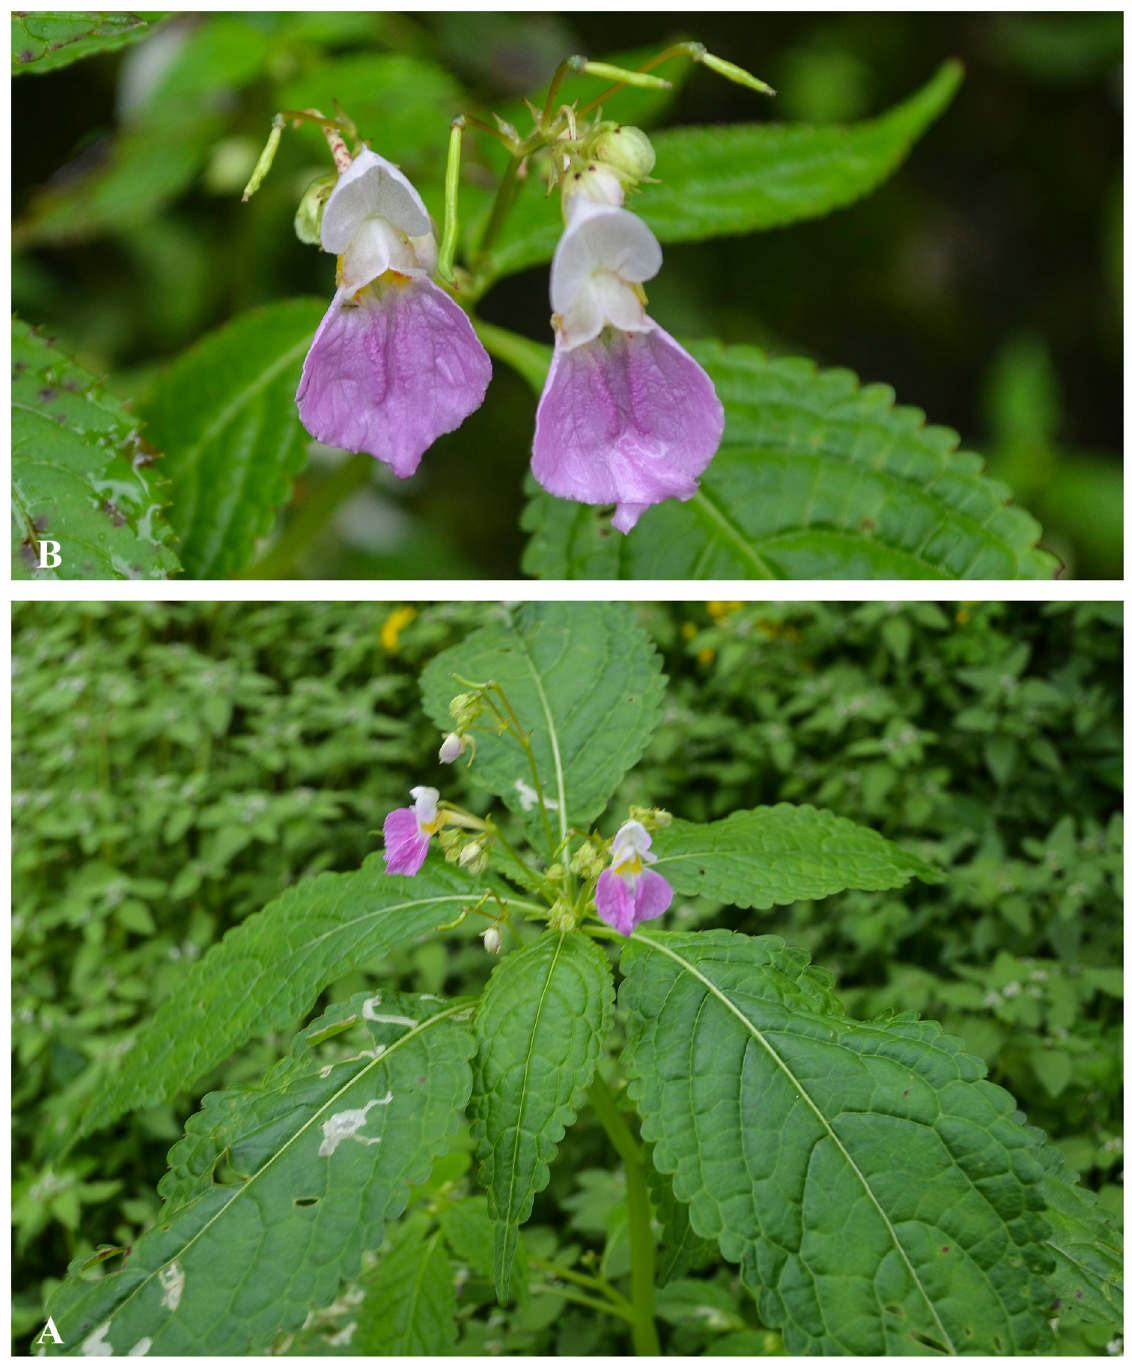
Fig 30. Impatiens sunkoshiensis A. Flowering plant; B. Flower (Front view). Photographs by Bhakta Bahadur